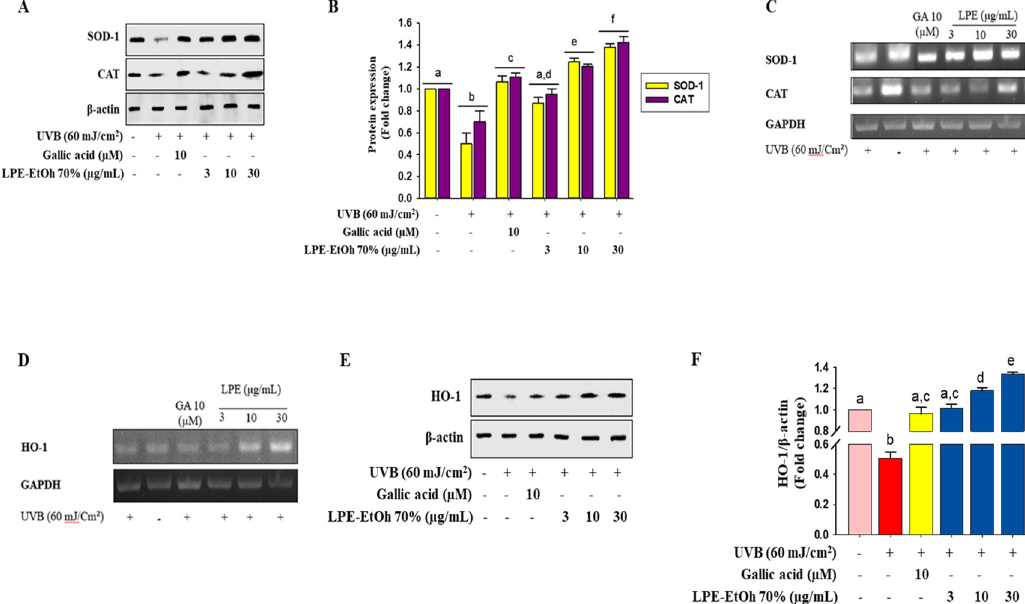
Figure 4. Analysis of primary and phase II antioxidant and detoxifying enzymes. HaCaT cells were pretreated with 2 µL ethanolic 70% extract of Lablab purpureus L. (LPE) for 24 h. Phase I antioxidant enzyme protein expression ( A ), band intensity analysis ( B ) and mRNA expression ( C ) were analyzed by Western blotting, image J software and RT-PCR, respectively. HaCaT cells were pretreated with LPE (3–30 µg/mL) for 24 h. The mRNA levels of phase II antioxidant were measured by RT-PCR ( D ). Concentration-dependent effects on HO-1 protein levels were analyzed by Western blotting ( E ) and band intensity analysis was performed by image J software ( F ). Statistical values are expressed as the mean ± SD ( n = 3). All the tests were performed in triplicate. Different letters stand for statistically significant each other ( p < 0.05) performed by one-way ANOVA followed by Tukey’s test. Orange color means non UVB-treatment; red color means UVB treatment, yellow color means gallic acid treatment; and blue color means sample (LPE) treatment.